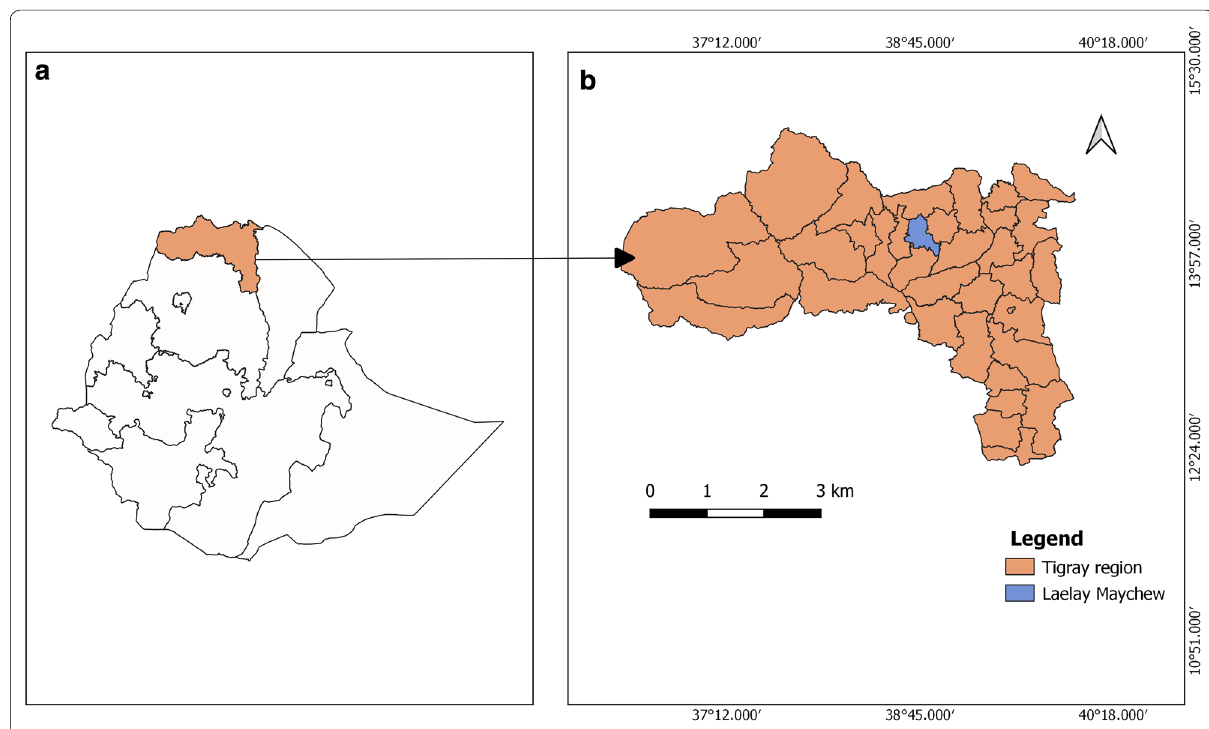
Fig. 1 Location map of study area: Tigray region in northern Ethiopia ( a ); and Laelay Maychew district in Tigray region ( b )